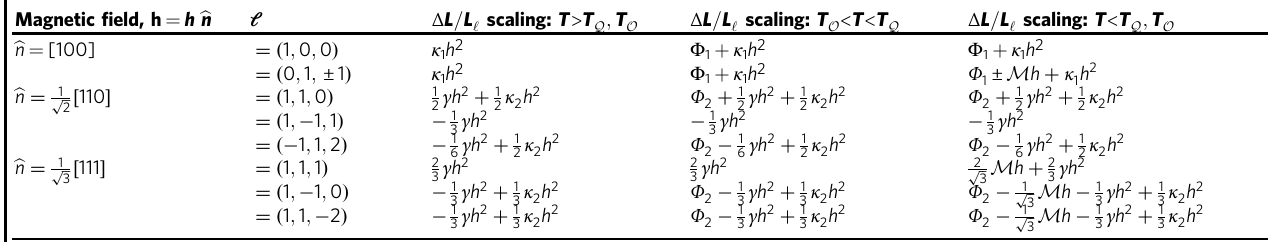
Table 1 Scaling relation for relative length change of system Δ L = L ‘ along direction ‘ for magnetic fi eld applied along b n direction Magnetic fi eld, h = h b